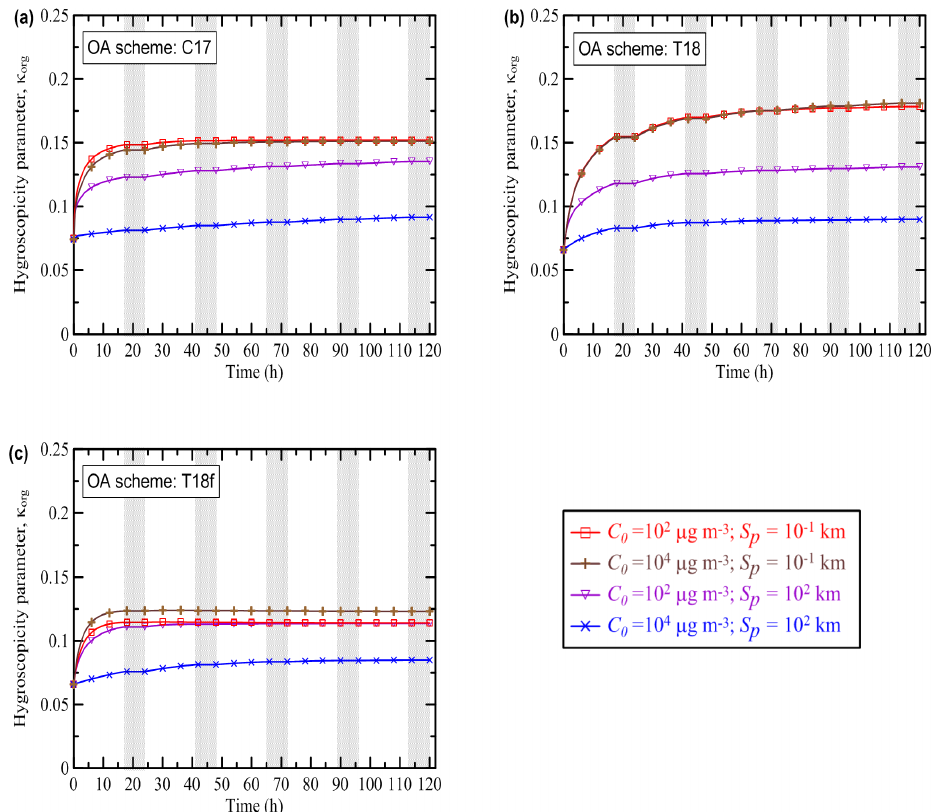
Figure 4. Evolution of the hygroscopicity parameter κ org simulated as a function of time with different values of the initial BB OA mass concentration, C 0 , and the initial BB plume size, S p , using the (a) C17, (b) T18, and (c) T18f schemes. Shaded bands depict nighttime periods when no oxidation reactions were allowed to